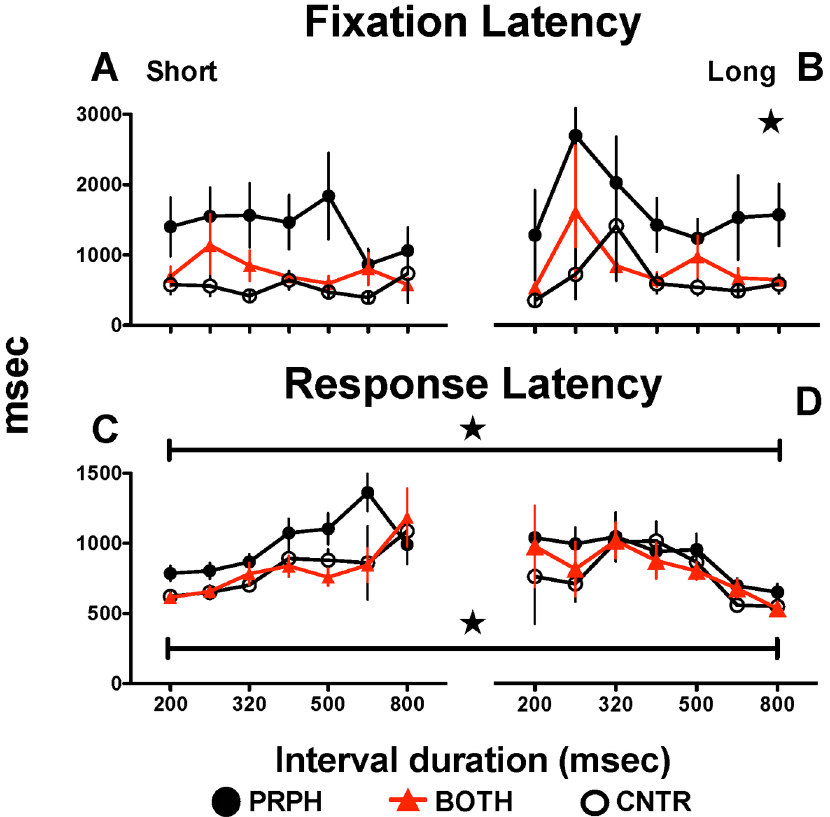
Fig 2. Fixation and response latency to “ short ” and “ long ” levers on generalization trials. Upper panels present latency to attain a 100 msec fixation on trials where subjects later responded to the 200 (A) or 800 (B) msec keys; lower panels present latency to emit categorization response of stimulus duration by responding to the 200 (C) or 800 (D) msec key. The performance of subjects (N = 15) of the CNTR group is represented by open circles while closed circles represent the performance of subjects (N = 15) of the PRPH group; the group that used BOTH is presented with red triangles. Only symbols at intervals close to or at the extreme durations present mean of 15 subjects since some subjects never emitted erroneous categorizations (e.g. response to 200 msec key after an 800 or larger than 400 msec stimulus). Stars and horizontal bars indicate significant differences between denoted groups after two-way ANOVA followed by Bonferroni´s test (p < 0.05) (see text); only data from anchor intervals with N = 15 were included in statistical